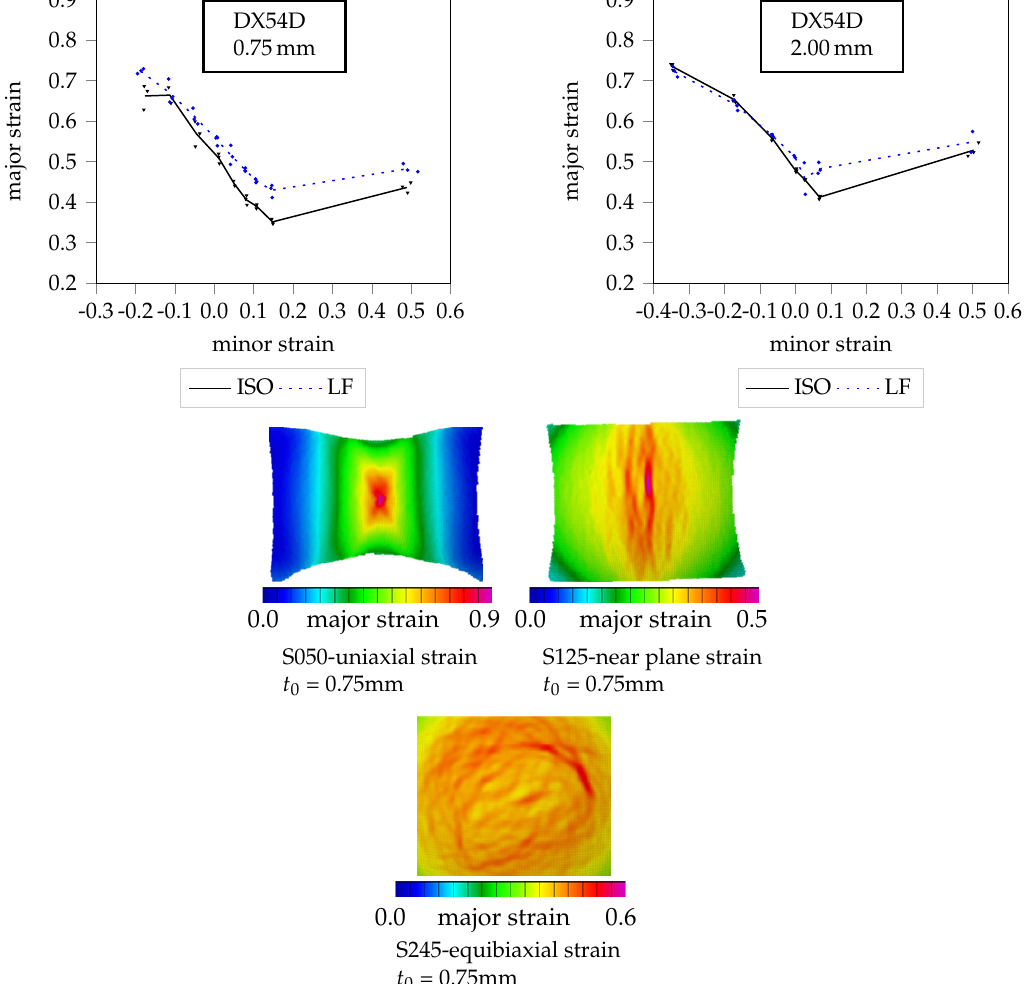
Figure 2. FLC of DX54D (0.75 mm) and DX54D (2.00 mm) with Aramis visualizations of the strain distributions one step before